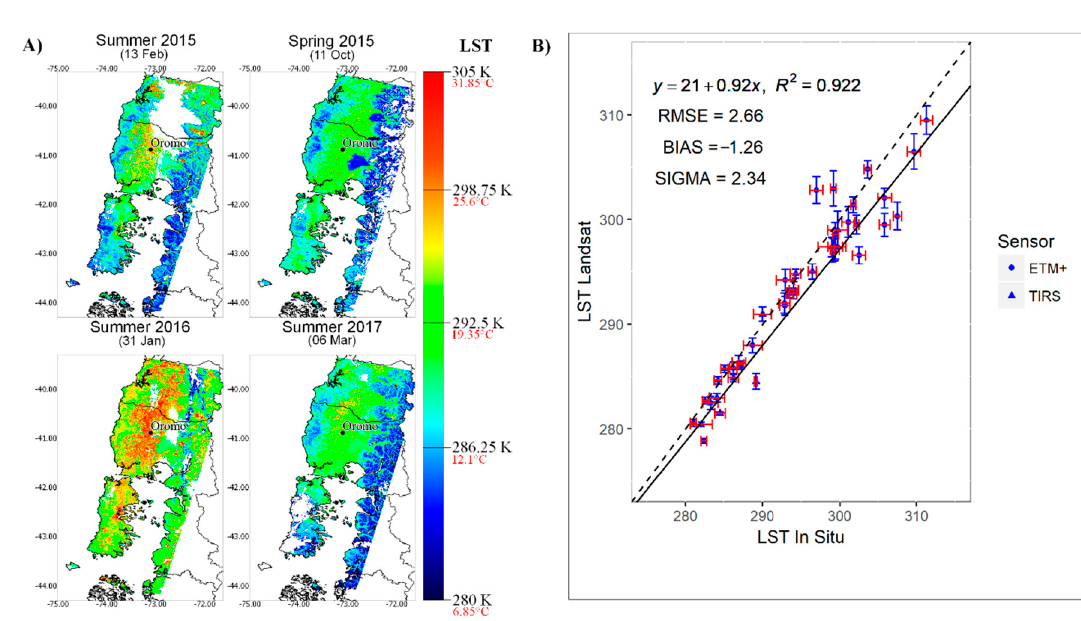
Figure 2. Estimates of surface temperature and comparison with in-situ measurements. ( a ) Satellite-based estimates of T s for the study area during selected spring and summer days. White gaps in the images represent regions with cloud cover. ( b ) Local comparison with in-situ measurements at the Oromo calibration site.